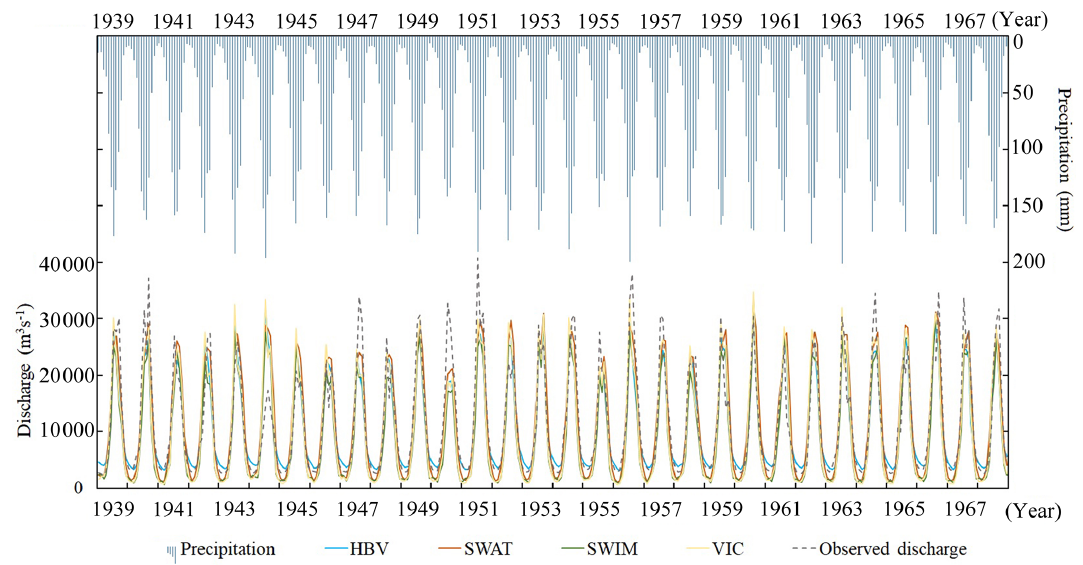
Figure 7. Observed and simulated monthly discharge and precipitation at the Cuntan station in the upper Yangtze basin for